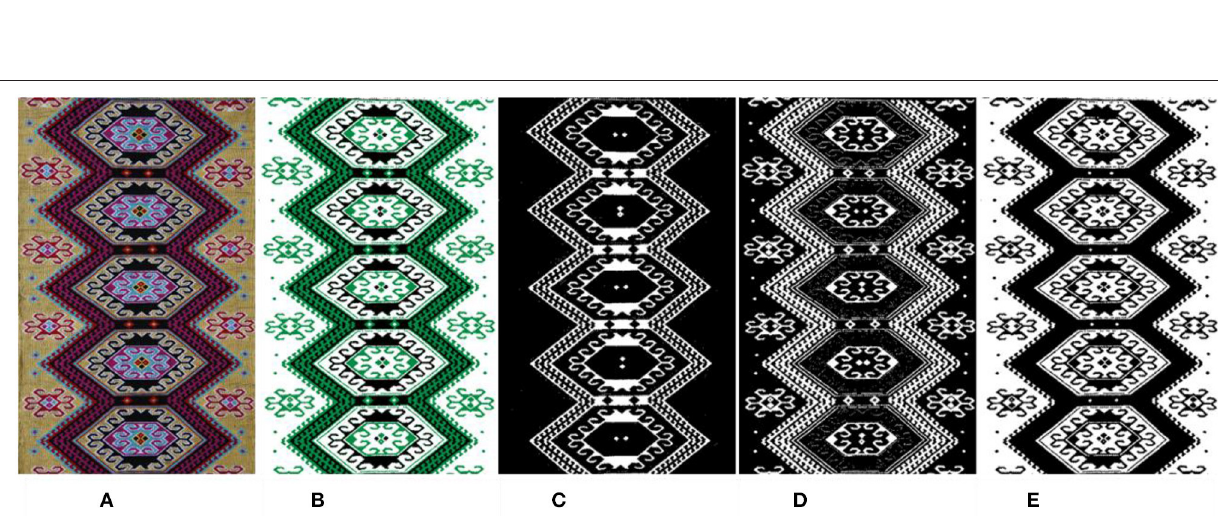
Frontiers in Neurorobotics |